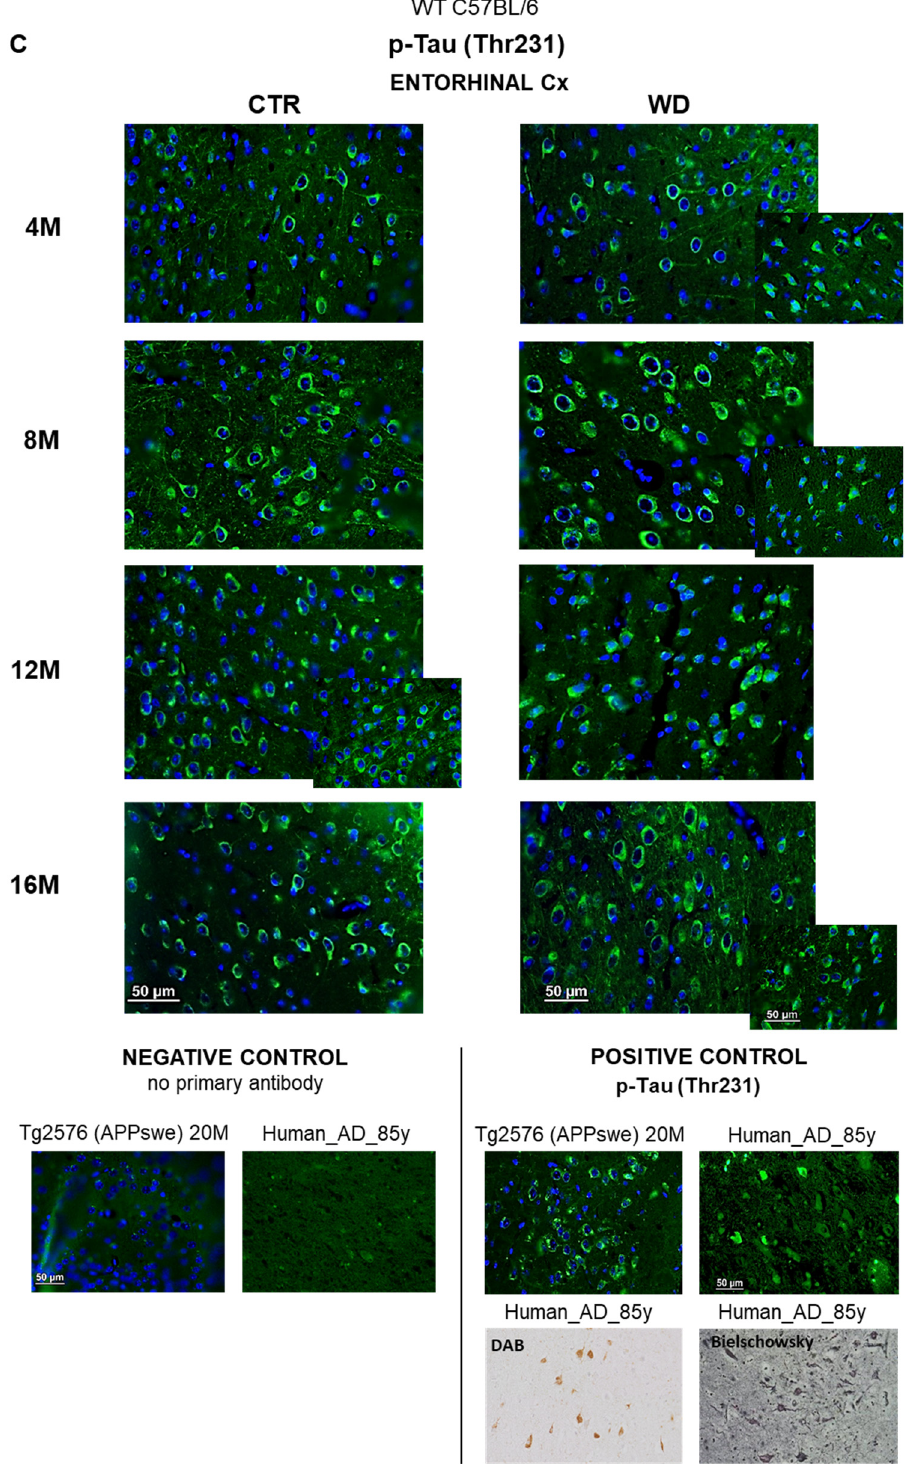
Figure 2. The levels of brain insulin signaling markers and tau phosphorylated at threonine 231 residue in entorhinal cortex of WT C57BL/6J mice. ( A ) Quantification and statistical analysis. ( B ) Representative source Western blots. Statistical analysis comprised the Shapiro–Wilk normality test, two-way ANOVA, and Tukey’s post hoc test; significant results: p-IRS-1 (Ser616): (4M WD vs. 8M WD ( p -Value = 0.0042); 4M WD vs. 12M WD ( p -Value = 0.0016); 4M WD vs. 16M WD ( p -Value = 0.0010); 12M CTR vs. 12M WD ( p -Value = 0.0084); 16M CTR vs. 16M WD ( p -Value = 0.0081)); p-GSK- 3 β (Ser9): (12M CTR vs. 12M WD ( p -Value = 0.0491)). The source figures from the Western blot anal- ysis are attached in Appendix A: Figure A1a,b; the completed statistical data are in the